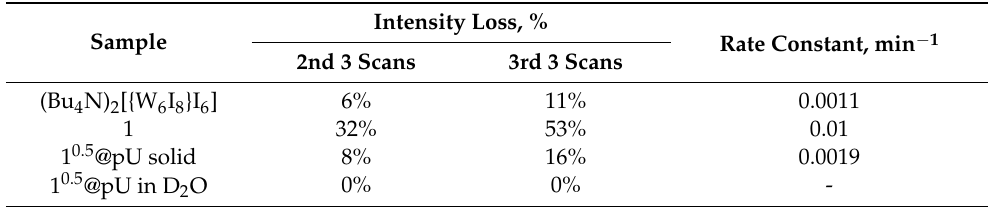
Figure 7. XEOL spectra during 3 h of irradiation for ( a ) (Bu 4 N) 2 [{W 6 I 8 }I 6 ], ( b ) 1, and ( c ) 1 0.5 @pU in solids and for ( d ) the D 2 O dispersion of 1 0.5 @pU. Each line is an average of three scans lasting 18 min each. Total time of irradiation was ~3 h. Table 1. Degradation of XEOL intensity under prolonged X-ray irradiation.